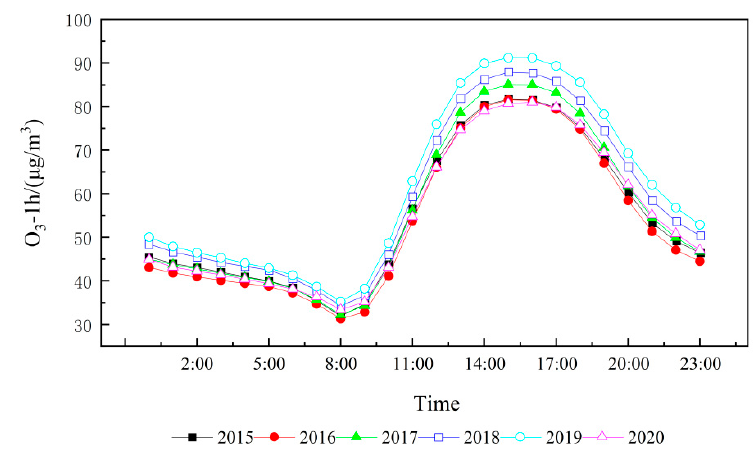
Figure 7. Daily trend of O 3 -1h in Yunnan from 2015 to 2020.